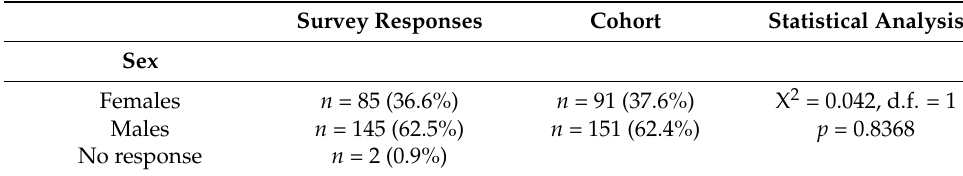
Table 1. Study participants.